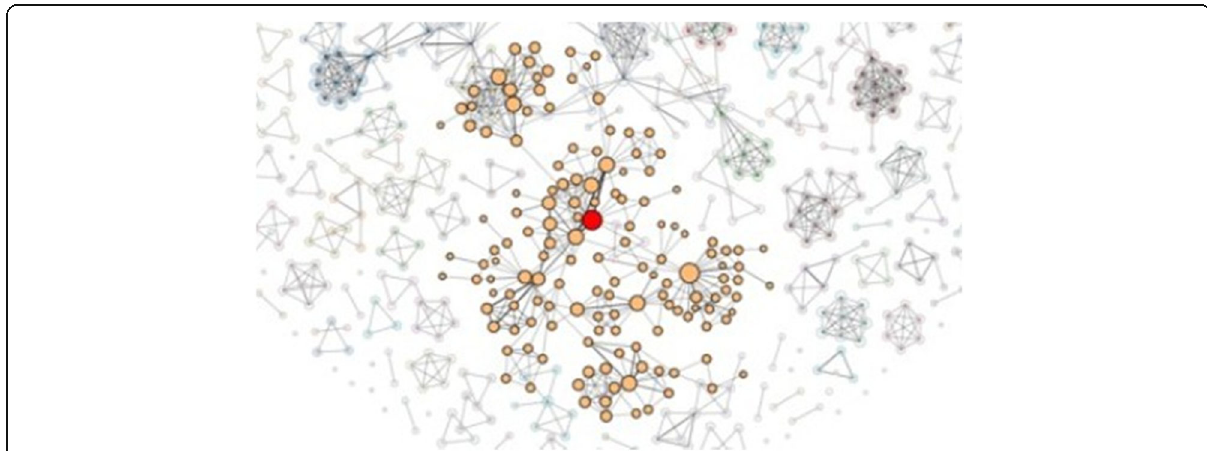
Fig. 14 Selecting a node representing the author Jock Mackinlay while applying a cluster detection algorithm based on nearest neighbors in the graph to compute a group of co-authors. It should be noted that, although this subgraph might be selected manually, it might not be exact, and a mixture of algorithmic and manual solutions is also